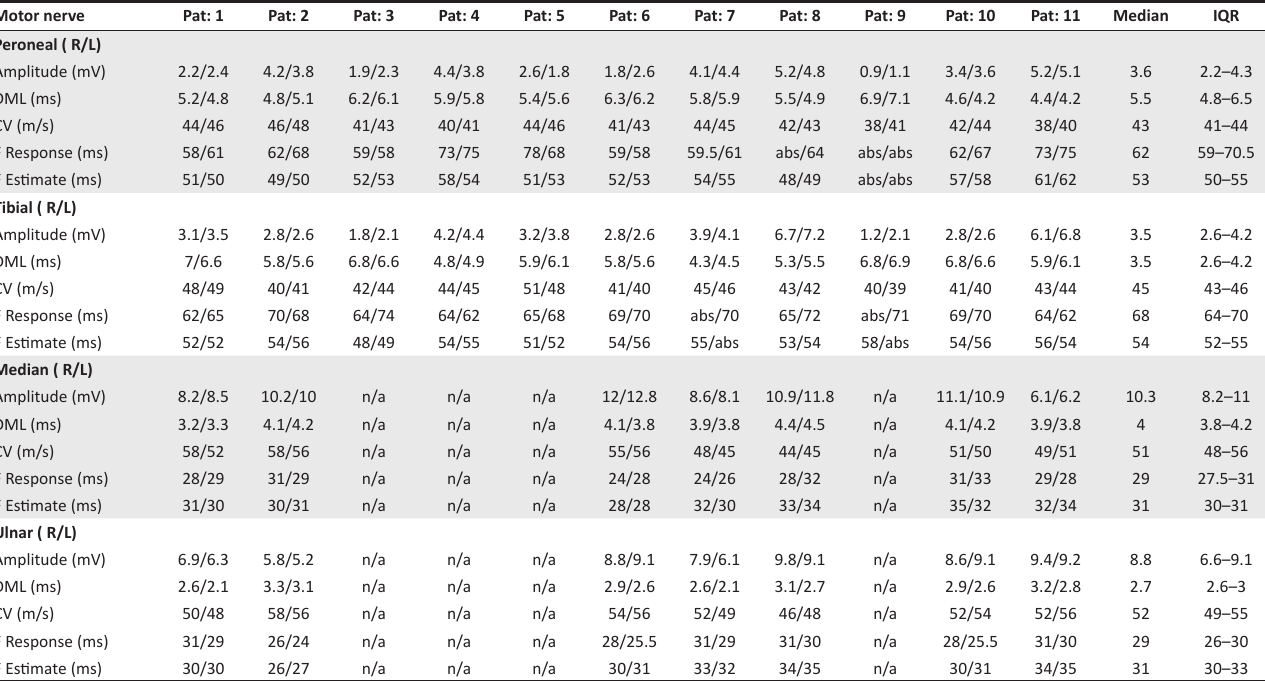
TABLE 2: Electrophysiological findings of patients with motor lumbosacral radiculopathy in HIV-infected patients: Motor studies. Motor nerve